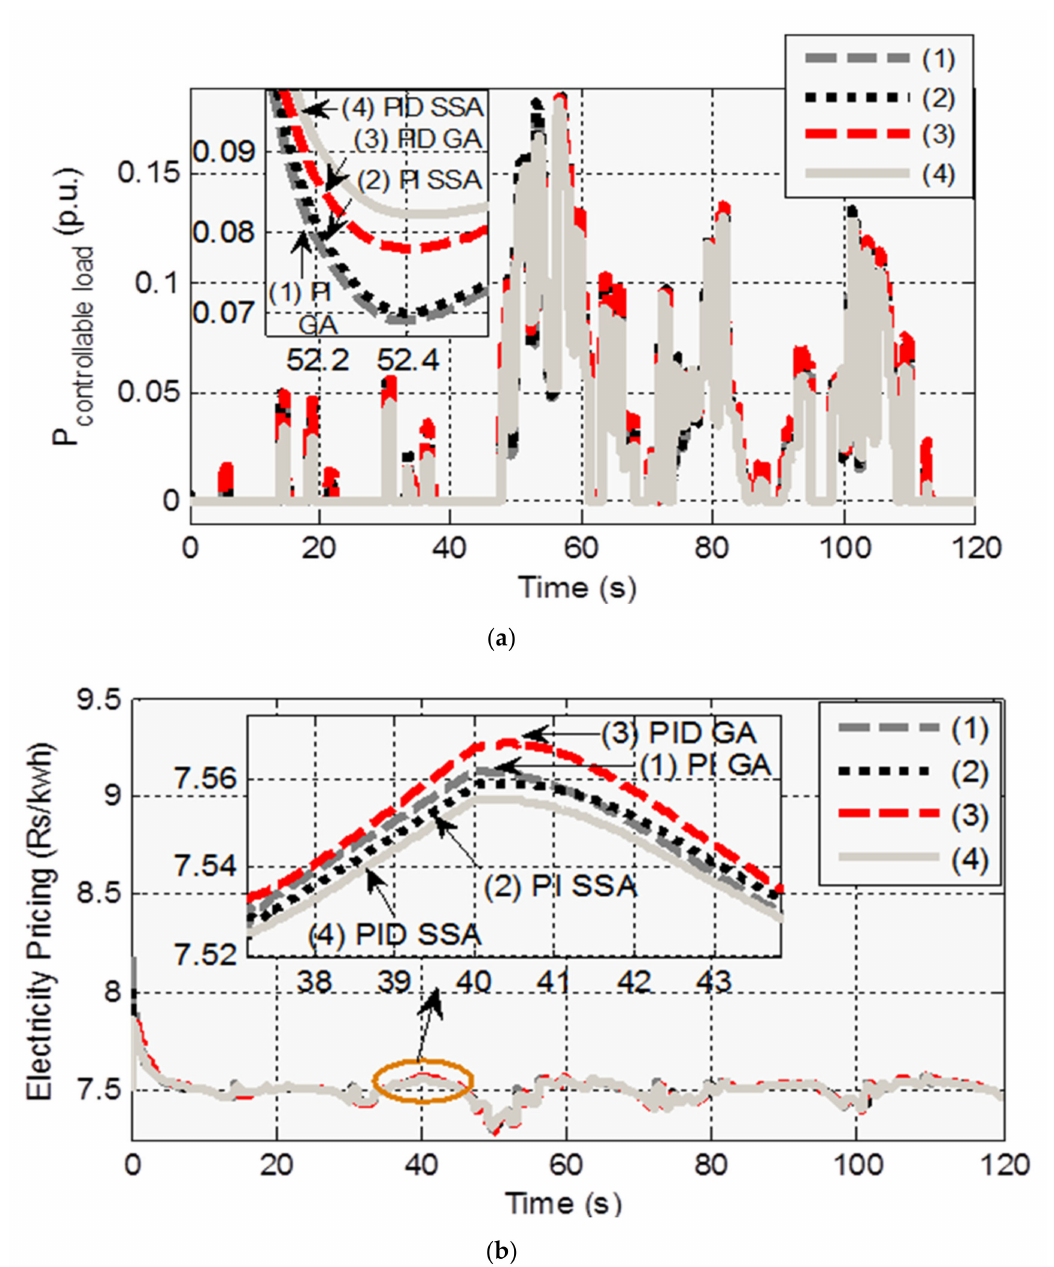
Figure 6. ( a ) Controllable thermostatic loads with PBDR. ( b ) Change in electricity pricing with the change in frequency, GA- vs. SSA-optimized with